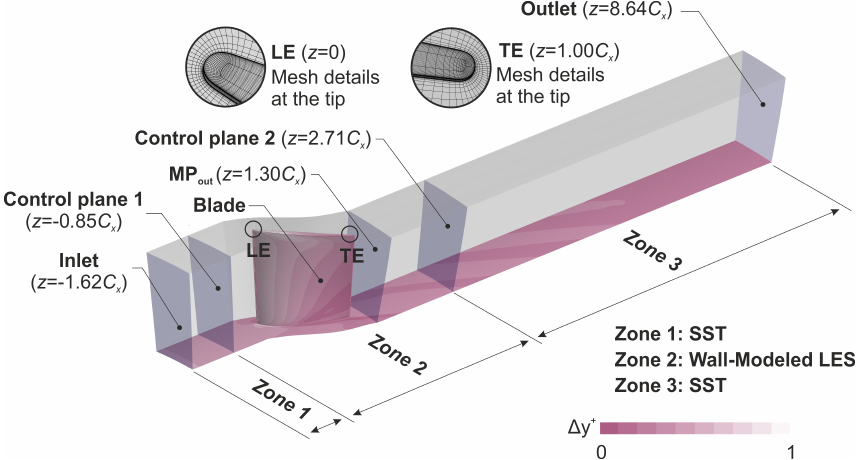
Figure 2. Computational domain for the single